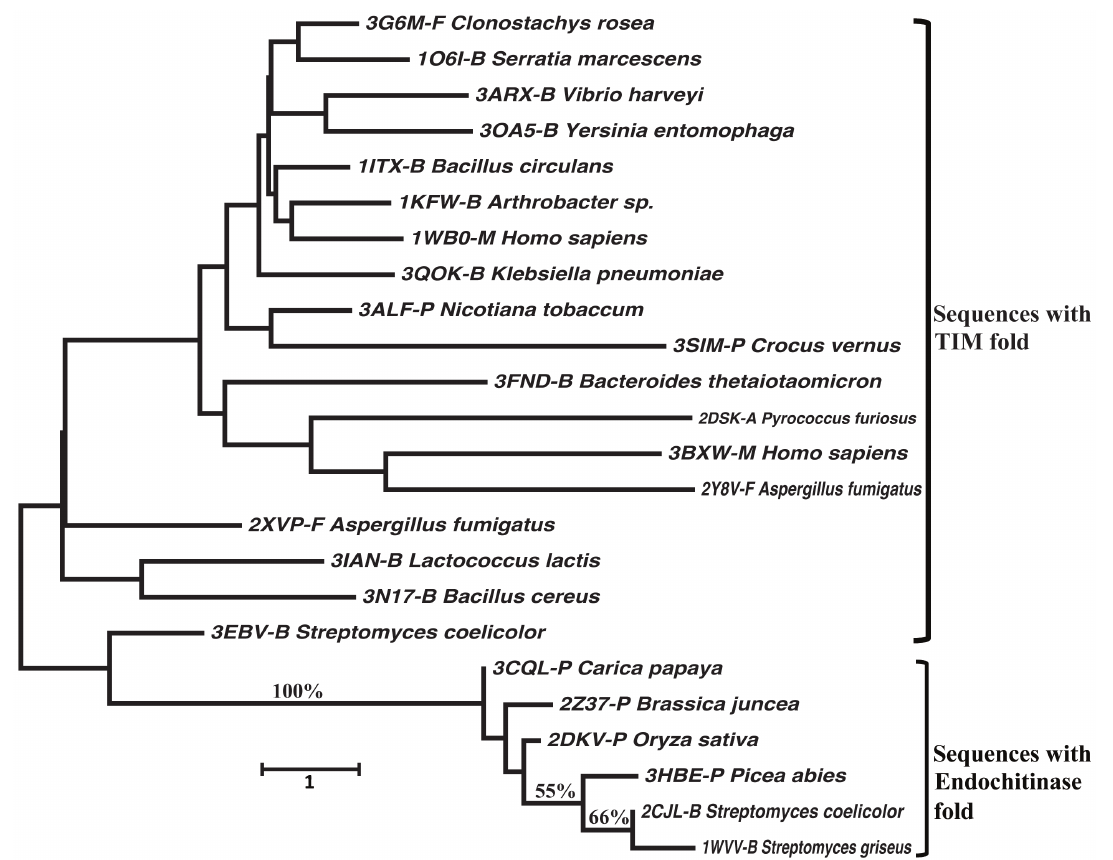
Figure 5. Phylogenetic analysis of selected 24 Chitinases for fold analysis. Bootstrap support value (%) . 50 is showed above branch.